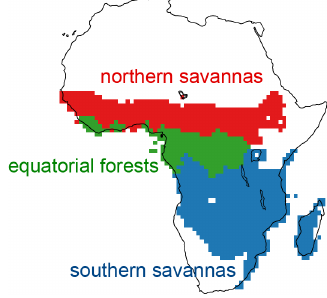
Figure 3. Coherent regions used for analysis of the factors con- trolling OMI-derived isoprene emissions. Land cover definitions are from the MODIS IGBP map (Fig.